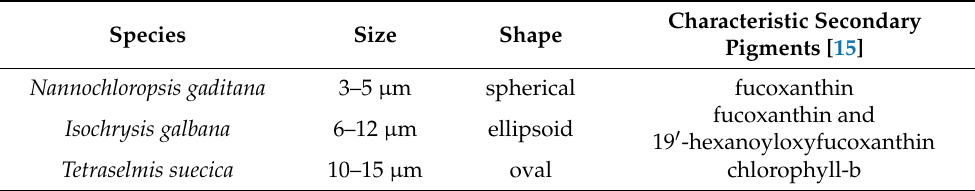
Characteristic Secondary Pigments [15] fucoxanthin and 19 (cid:48) -hexanoyloxyfucoxanthin